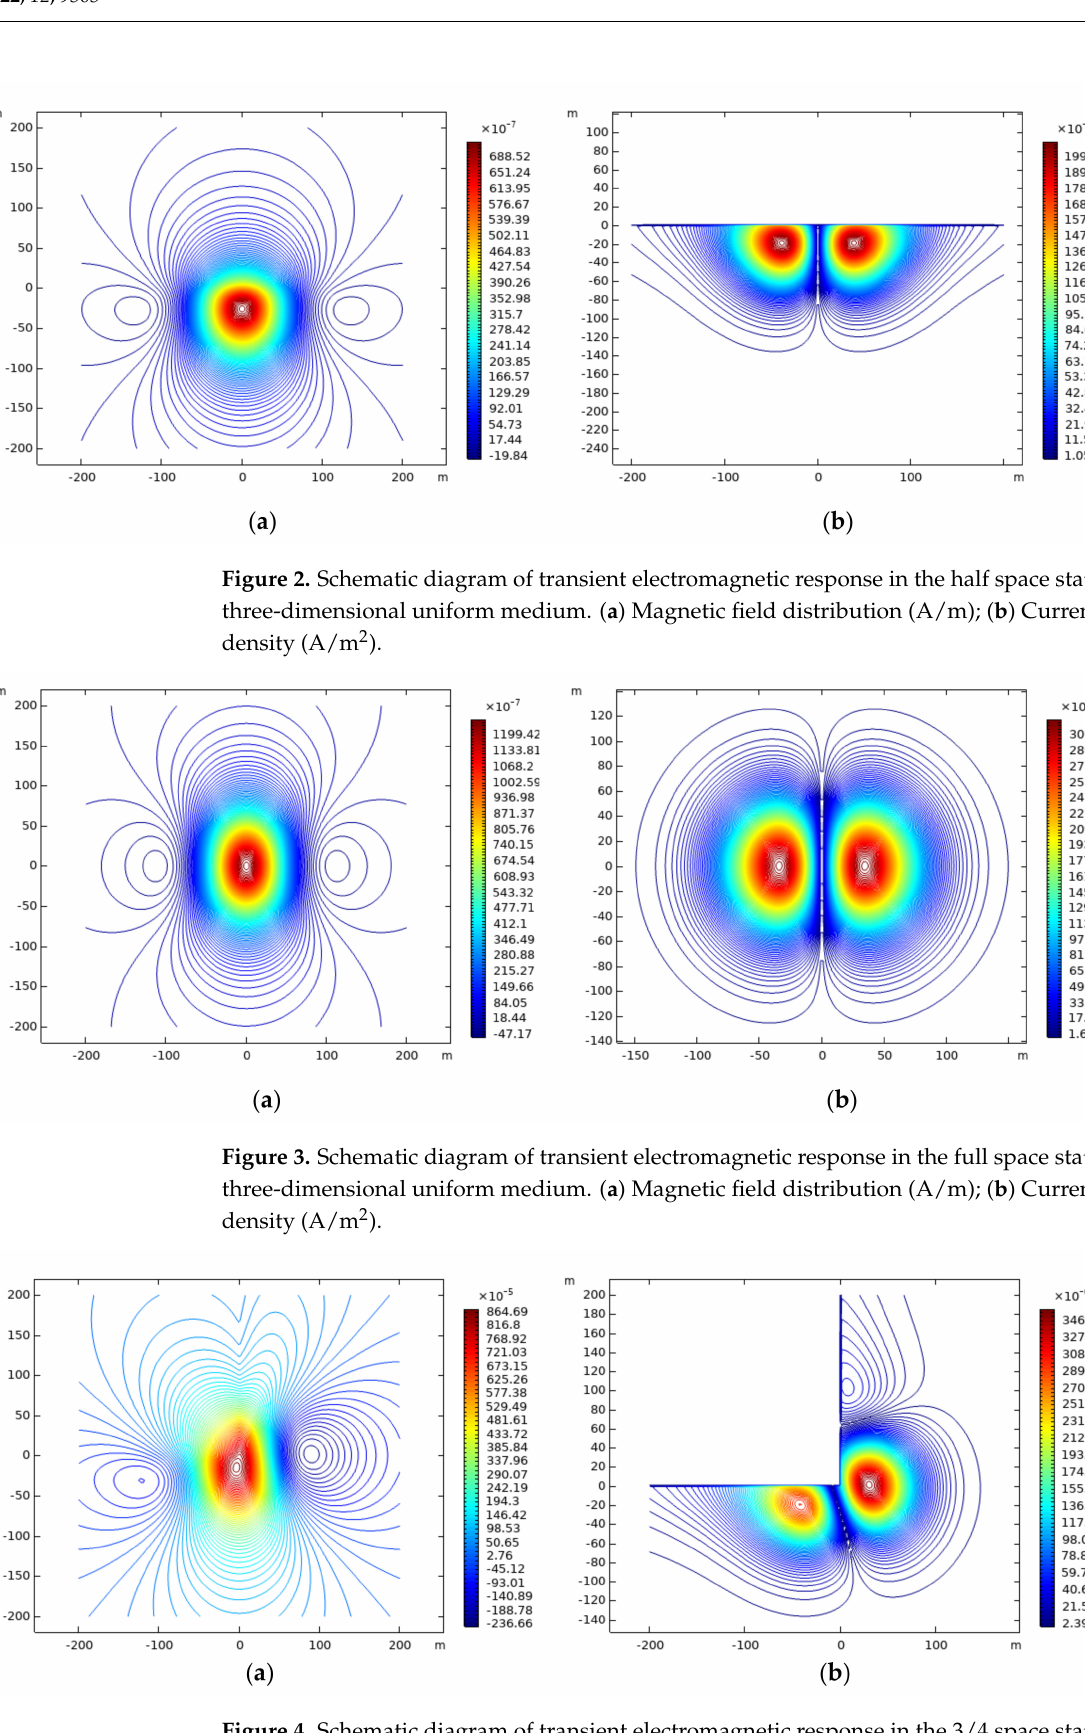
Figure 4. Schematic diagram of transient electromagnetic response in the 3/4 space state under the three-dimensional uniform medium. ( a ) Magnetic field distribution (A/m); ( b ) Current induction density (A/m 2